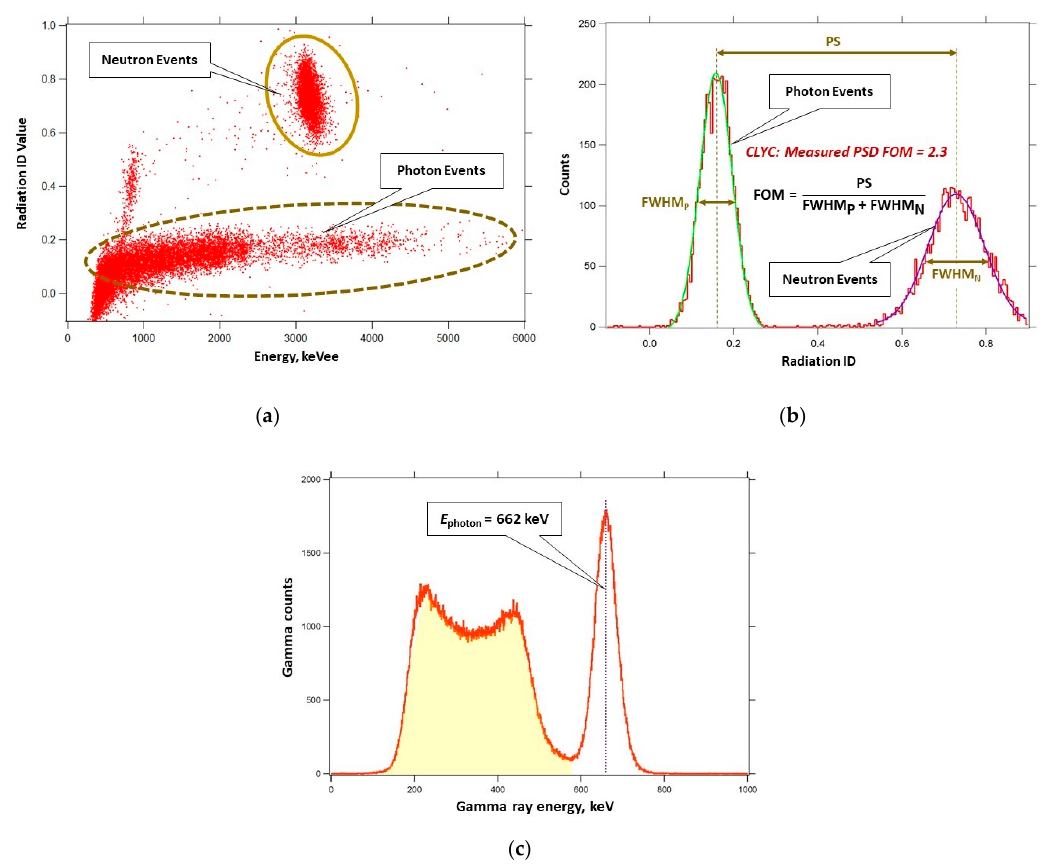
Figure 9. ( a ) Neutron/gamma pulse shape discrimination diagram of the CLYC sensor measurements in a mixed radiation flux using a PuBe source; ( b ) pulse shape discrimination (PSD) figure of merit measurement for CLYC sensor (figure of merit (FOM) = 2.3); ( c ) gamma spectrum recorded by the CLYC sensor for a 137 Cs source (measured full widths at a half maximum (FWHM) energy resolution is <5% at 662 keV). Table 1. Gamma ray FWHM energy resolution of the CLYC sensor.